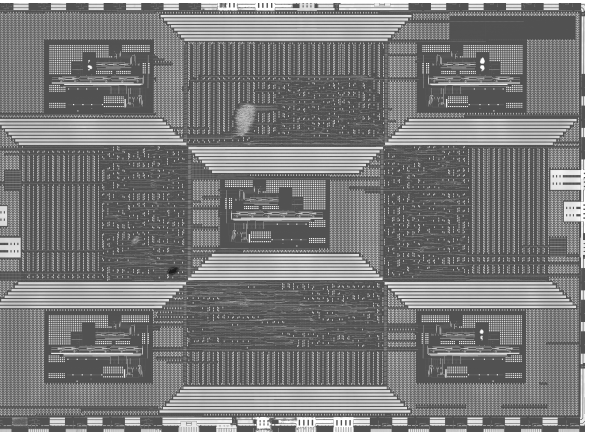
Figure 1. A scanning electron microscope image of the chip with a resolution of 6960 × 5084.